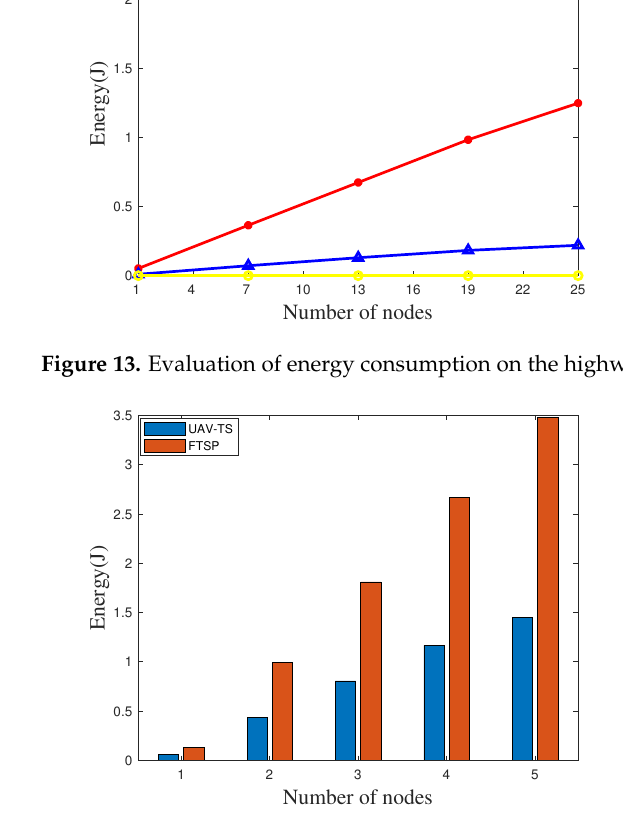
Figure 14. Comparison energy consumption with FTSP on the